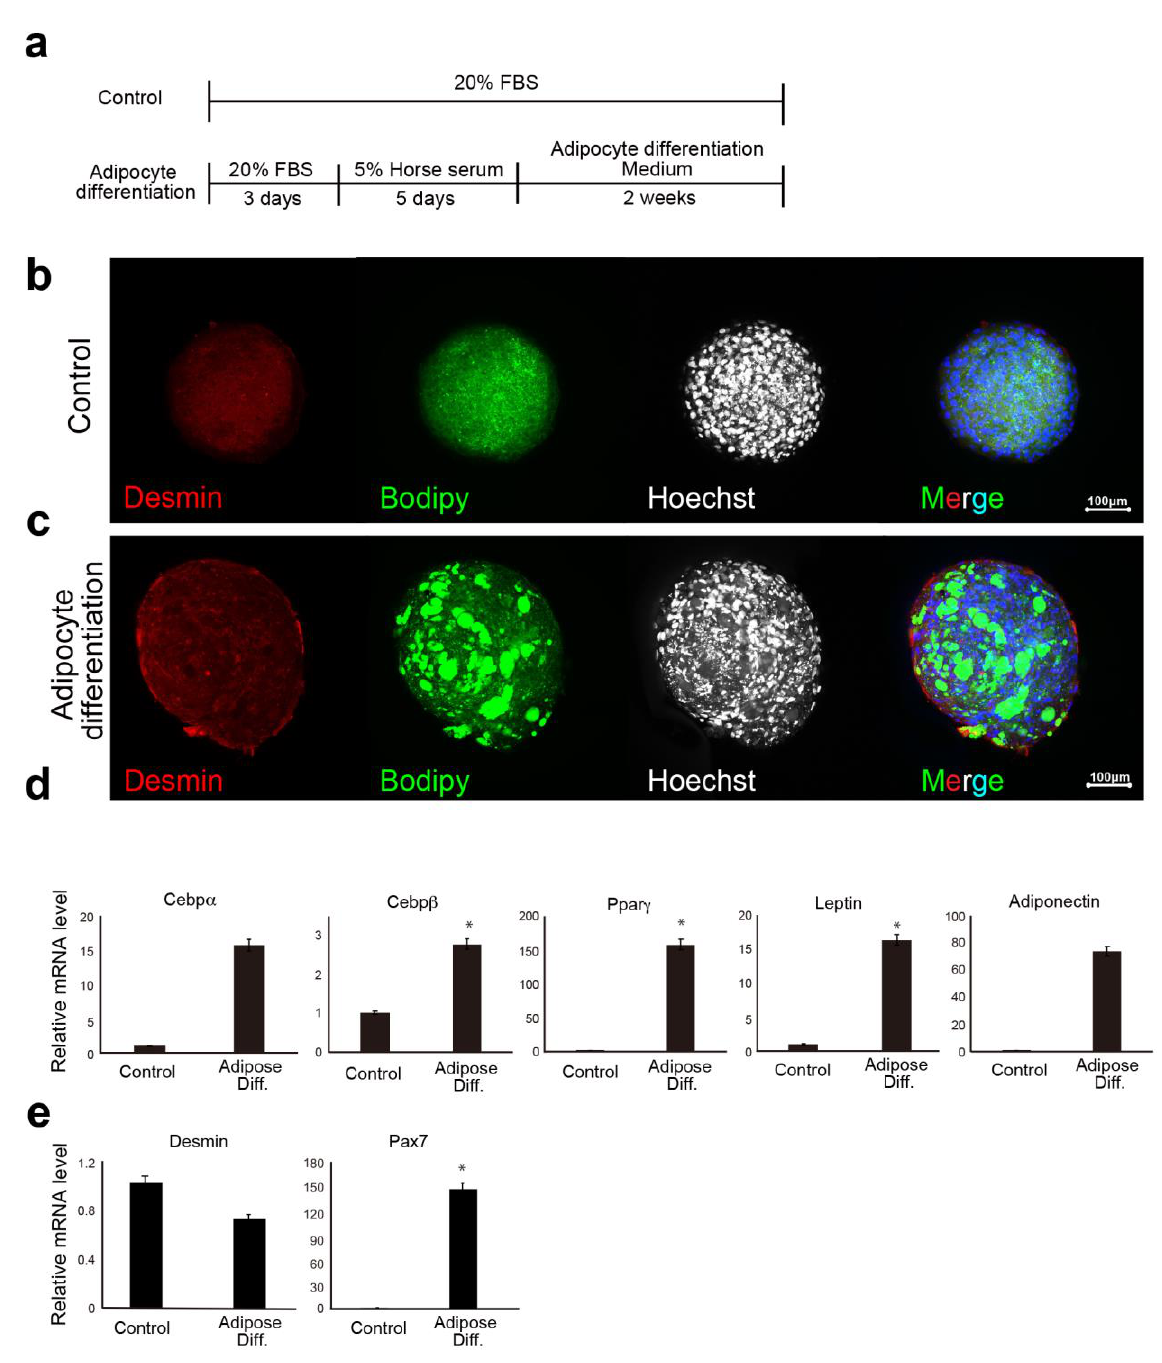
Figure 4. Induction of lipid accumulation and lipid measurement in meat buds. ( a ) Scheme of CD29+ cells with adipogenic differentiation. ( b , c ) Spheroids prepared from Ha2/5+ cells were differentiated into adipose differentiation medium for two weeks after five days of differentiation into muscle. Control spheroid ( b ) and spheroids induced to adipose differentiation ( c ) are shown. Desmin (red), BODIPY (green), and Hoechst (Blue). The scale bar represents 100 µ m. ( d ) Relative expression of bovine meat bud by real-time RT-PCR. RNA was extracted from adipose-differentiated bovine meat buds (two weeks) for gene expression analysis of adipose differentiation markers ( CEBP α , CEBP β , PPAR γ , LEPTIN , and ADIPONECTIN ), and ( e ) muscle markers ( DESMIN and PAX7 ). ( n = 4), * p < 0.05.